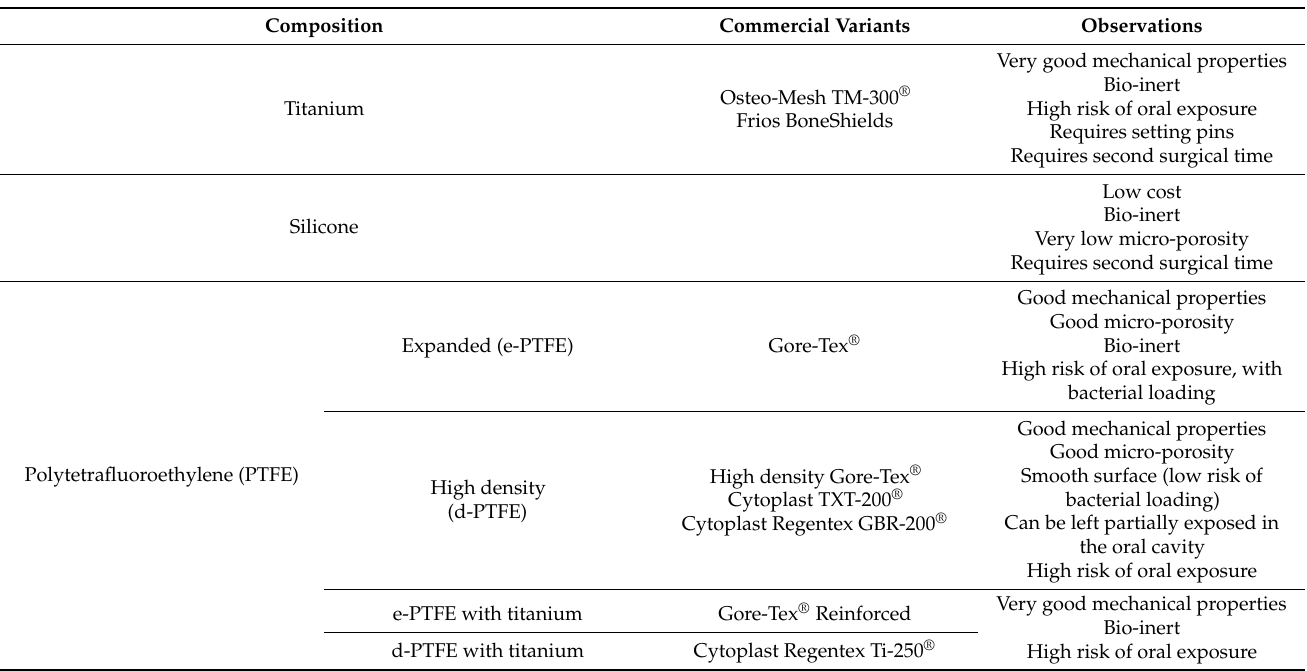
Table 1. Types of non-absorbable